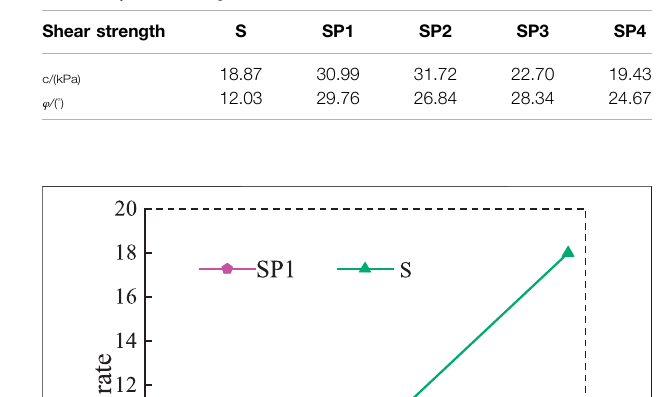
TABLE 5 | Shear strength index of SP mixed silt.